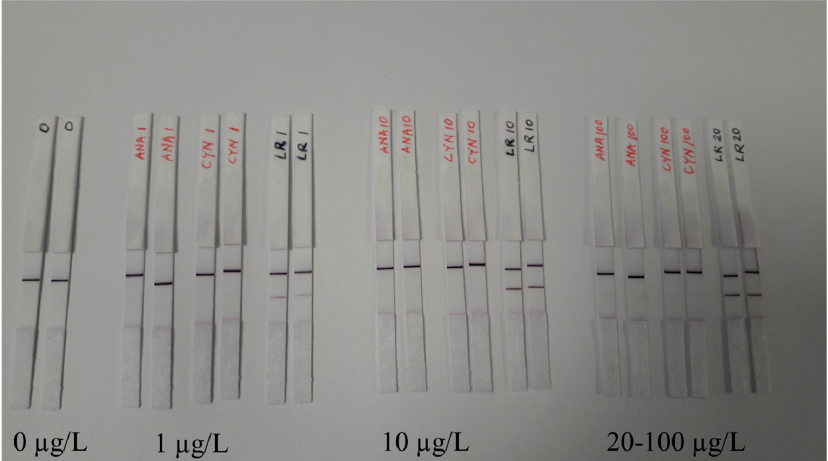
Figure 5. Test of possible interferences of the LFIA in the presence of other water soluble toxins. No false positive result was observed in the LFIA in the presence of 100 µg/L of anatoxin-a (ANA) or cylindrospermopsin (CYN). Blank result and positive result with microcystin-LR (1-20 µg/L) are compared.